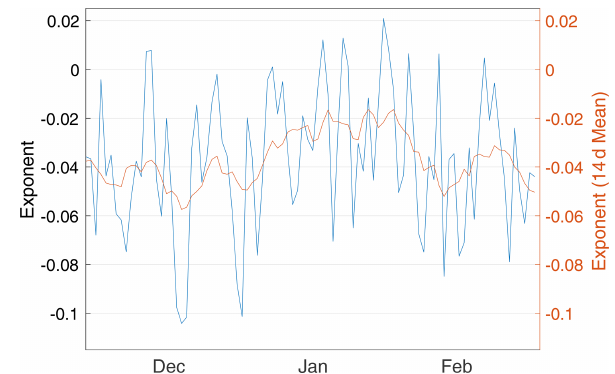
Figure 11. Spatial scaling exponents of the total deformation for q = 1 for daily fields during winter. The region analyzed is outlined in the first panel in Fig. 7. Model output with the TS005 grid and NDTE = 960 is used for the analysis. The exponent sequence from daily fields (blue line, left y axis) is accompanied by its 14d running mean (orange line, right y